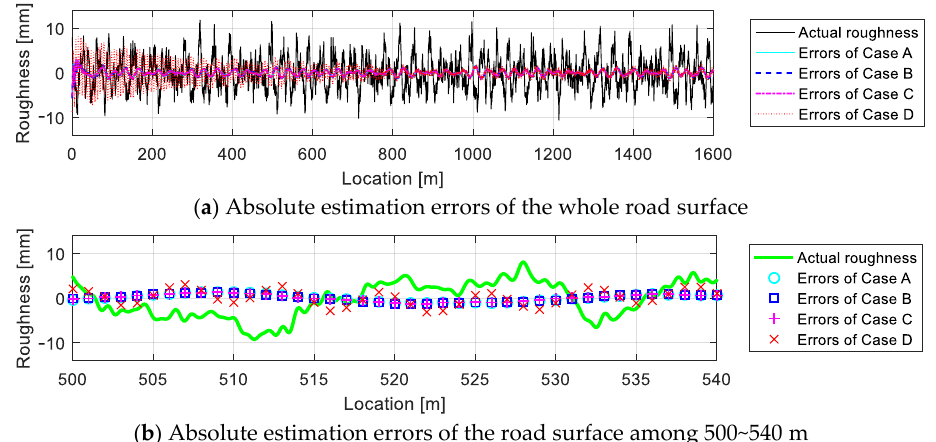
Figure 21. Estimated power spectral densities of the road roughness using sensors S 1 – S 3 for Case A via the measured responses in Case 1.